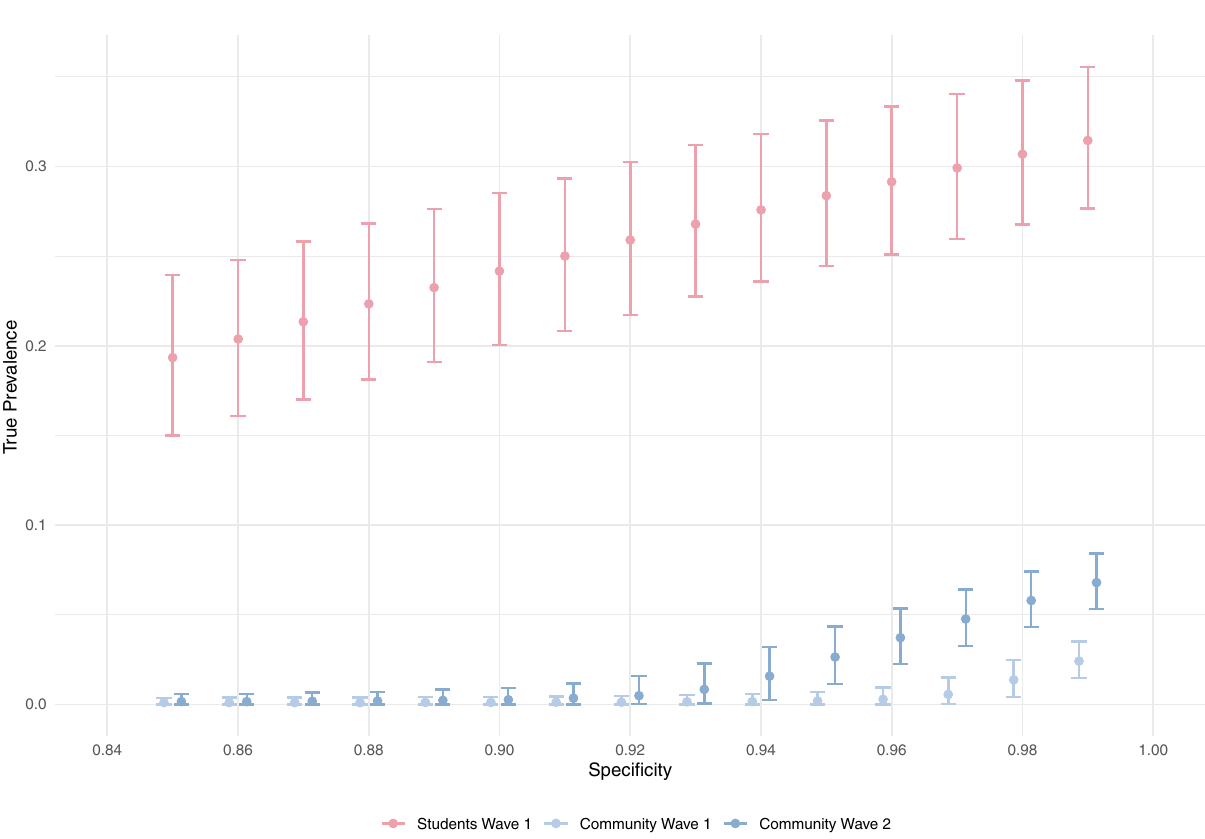
Figure 3. Estimated true prevalence (circles, with 95% confidence intervals) among participants at each sampling interval corrected for estimated assay sensitivity as a function of the assumed assay specificity (x-axis). Light blue indicates community residents at the first visit at the start of the Fall 2020 term, red indicates returning students at the end of the Fall 2020 term, and dark blue indicates community residents at the second visit after student